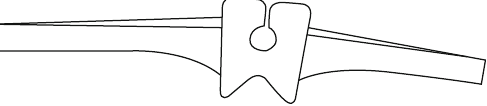
Figure 5: Avanta fi nger silicone